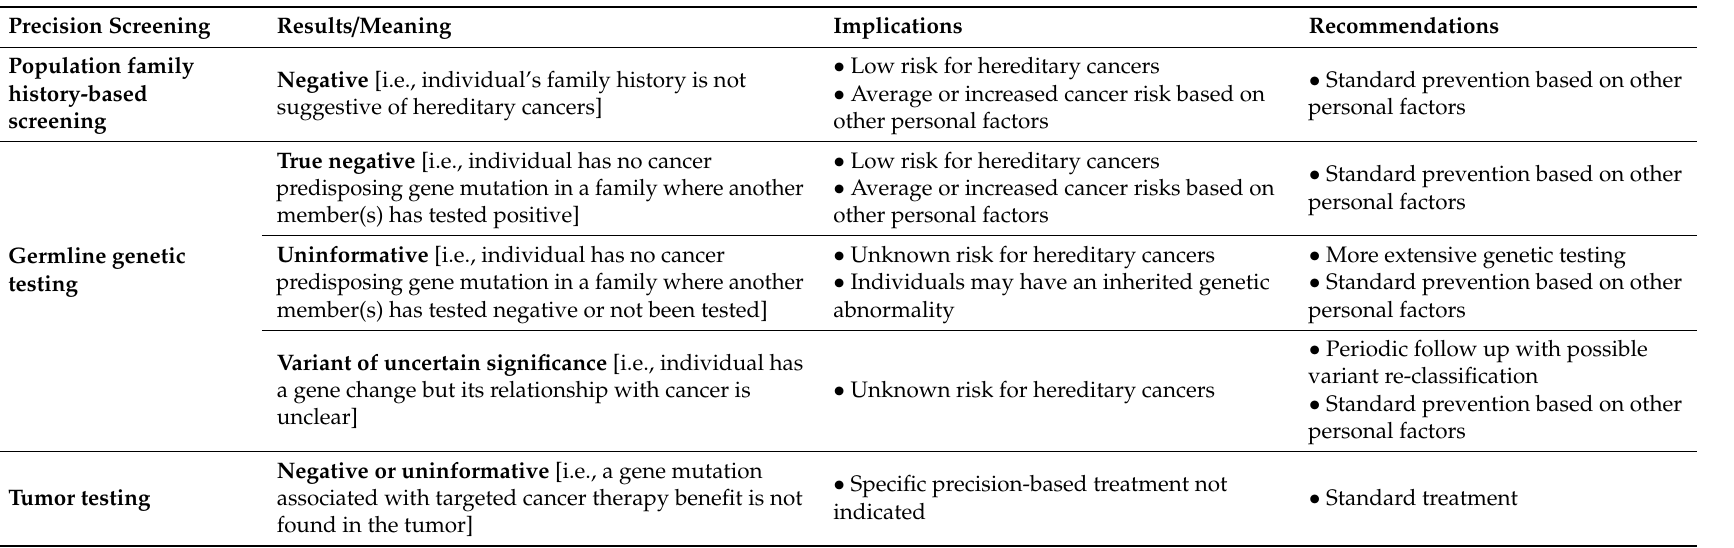
Table 1. Implications of negative results by level of precision